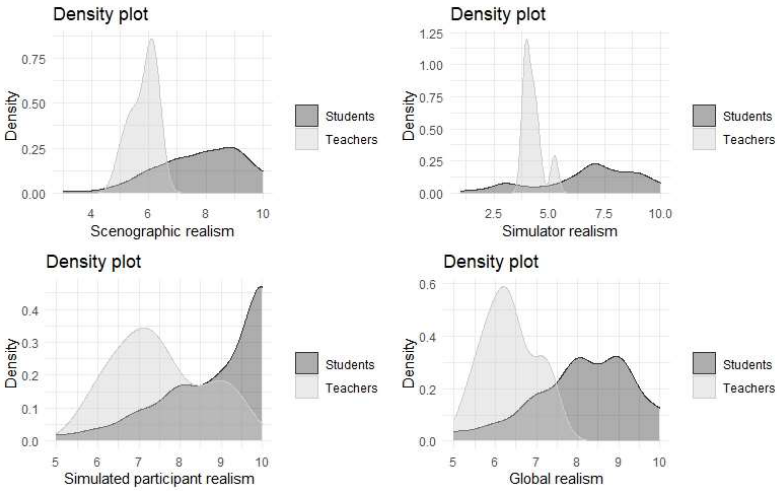
Figure 5 . Densities of realism as perceived by students and teachers .